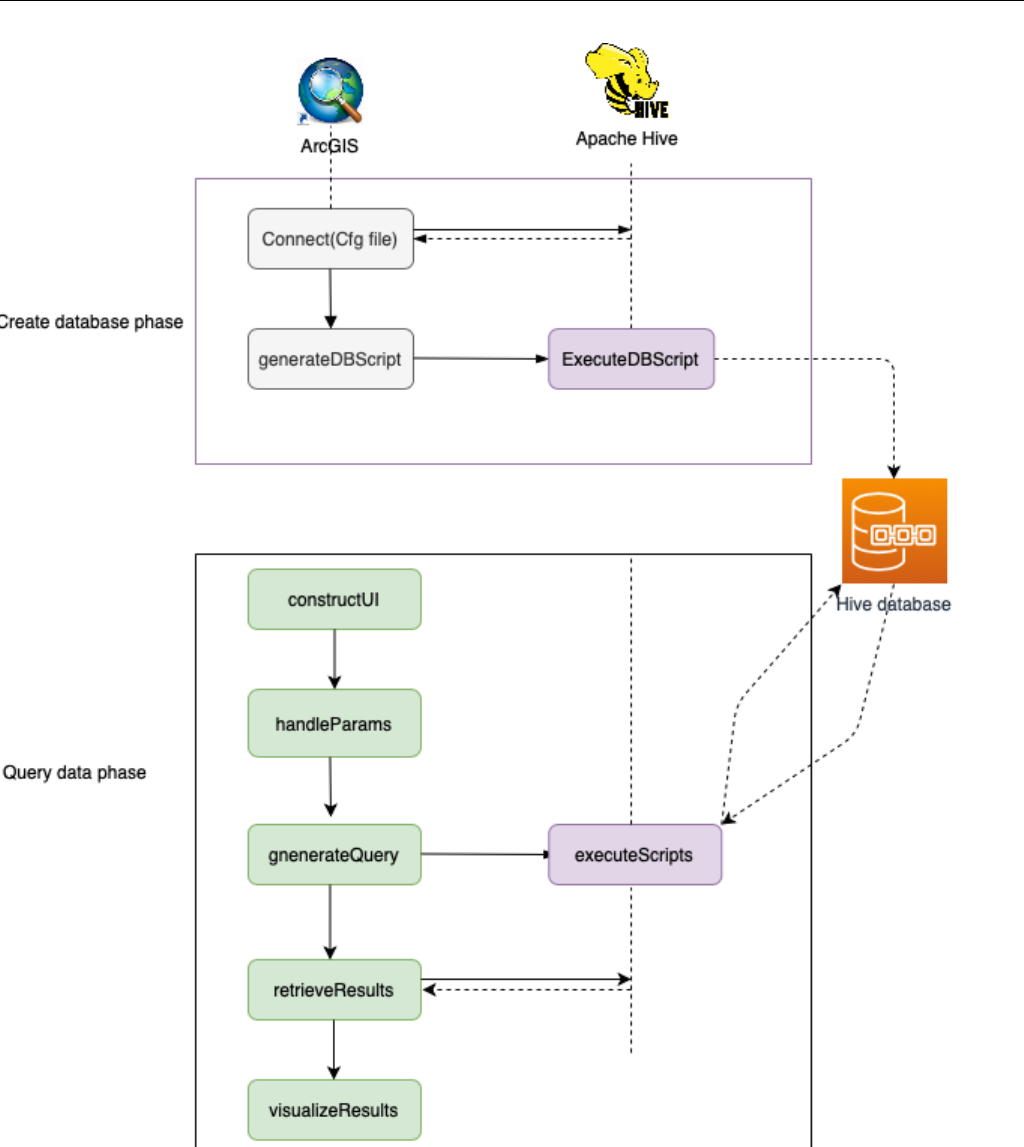
Figure 4. Steps integrating ArcMap toolbox with Hive